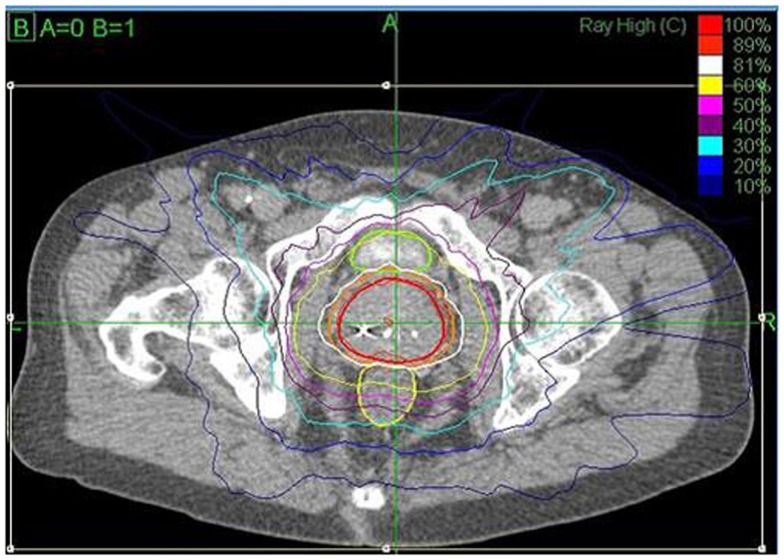
CyberKnife SBRT treatment plan (36.25 Gy × 5 fractions prescribed to the 81% isodose line (white) with a 44.75 Gy maximum dose). Shown are the prostate (43.6 cm3, red) and PTV (77.8 cm3, orange). A bladder (green) volume of 1.66 cm3 received 37 Gy and 0.4 cm3 of the rectum (yellow) received 36 Gy.